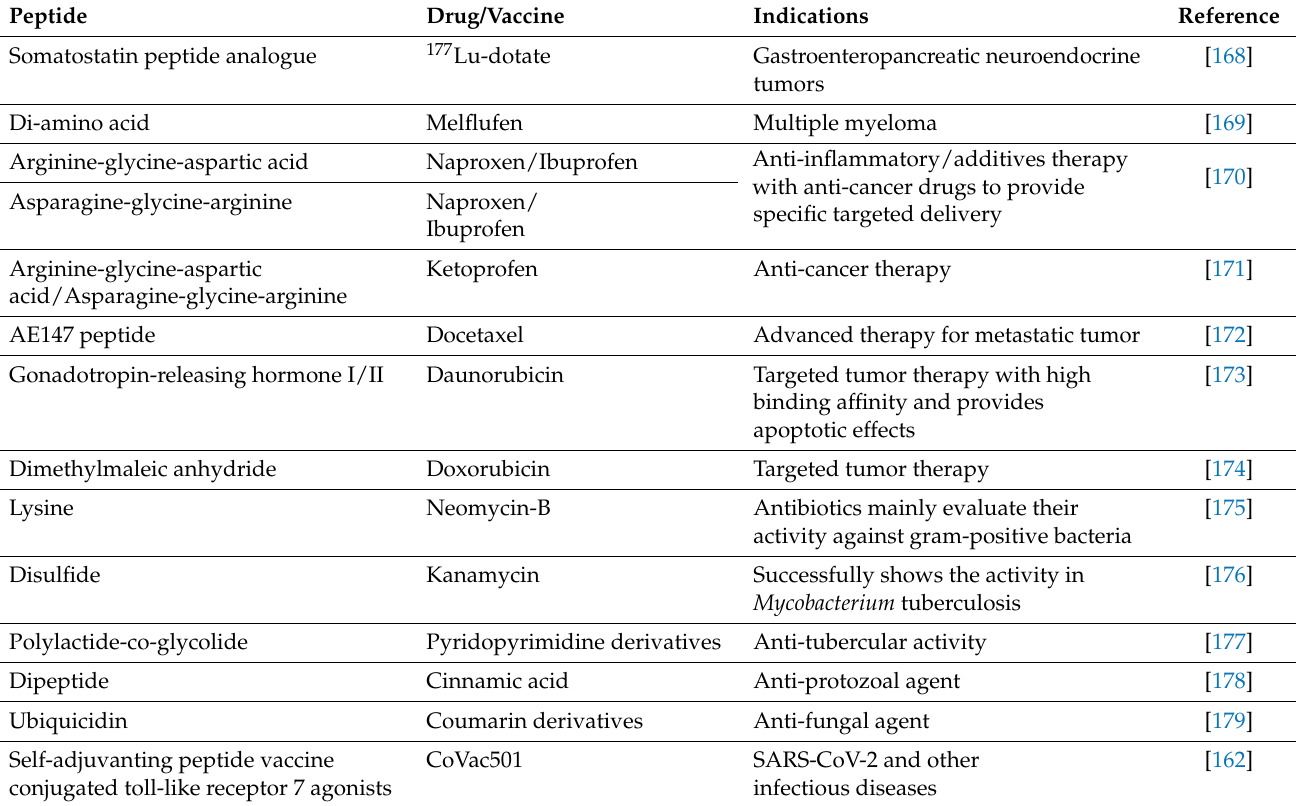
Table 4. Selected applications of